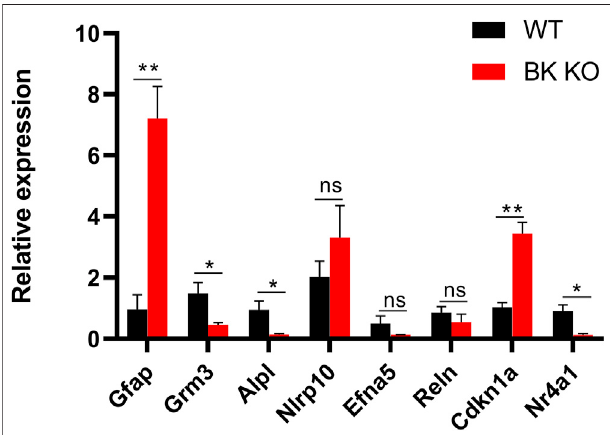
FIGURE 9 | Differential expression of mRNAs between the cortex and hippocampus of WT (Black) and BK KO (Red) mice validated by RT-PCR. Gfap and Grm3 associated with astrocyte activation, Alpl, and Nlrp10 associated with neuroin fl ammation, Efna5 and Reln associated with epilepsy,Cdkn1aandNr4a1associatedwithautophagy.Gfap,Grm3,Nlrp10, Alpl in cortex, and Efna5, Reln, Cdkn1a, Nr4a1 in hippocampus. Ns (no signi fi cant difference, p > 0.05), p p < 0.05, pp p <